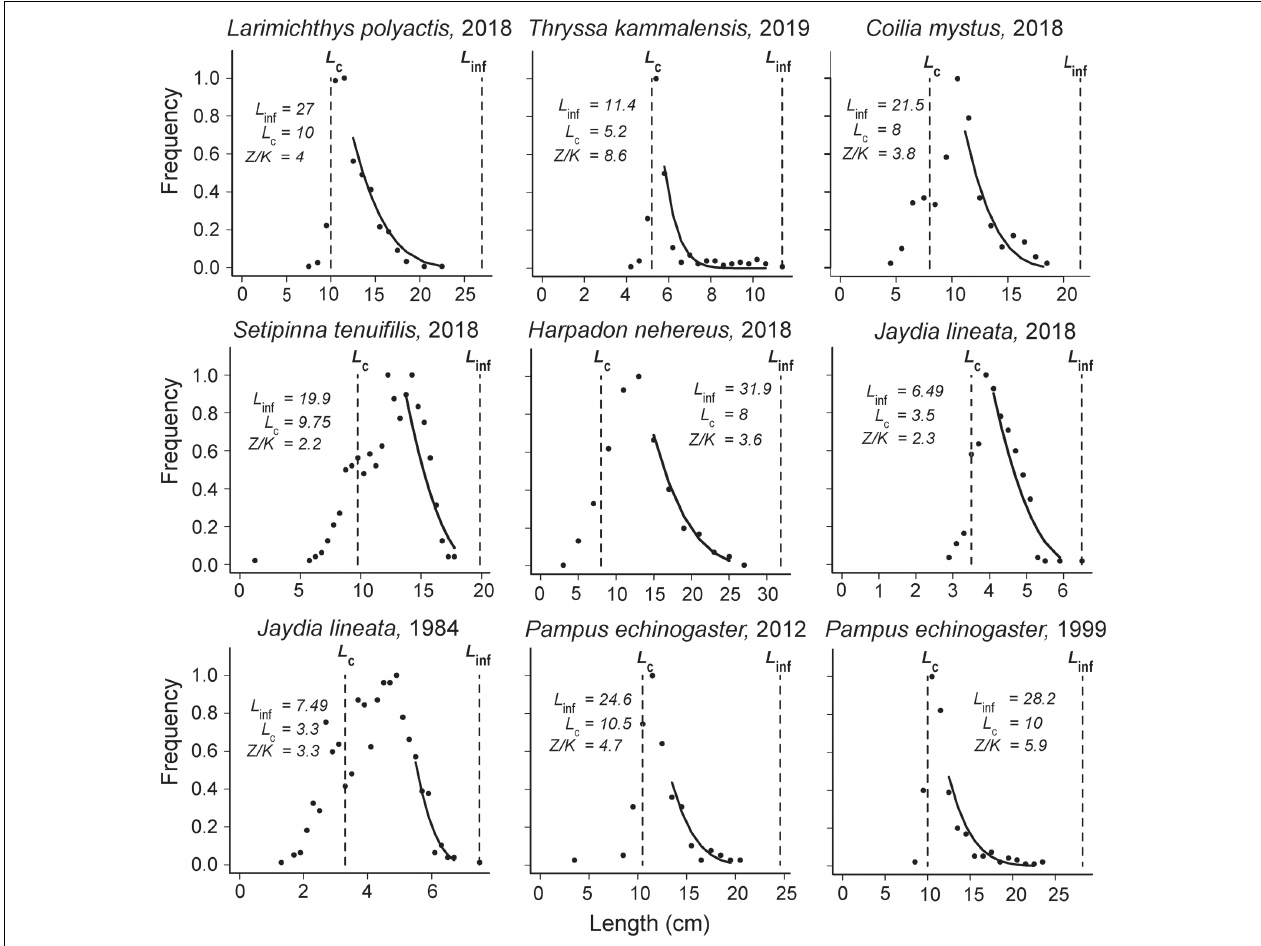
FIGURE 2 | Fitness to the fully selected part of the catch in the numbers curve used to obtain L inf (cm), L c (cm), and Z / K priors for the seven studied fish stocks. Black dots indicated the observed LF data.